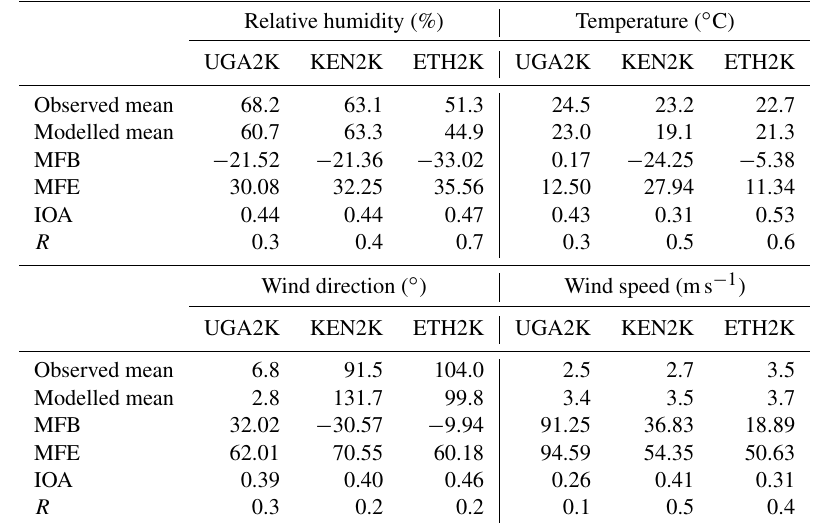
Table 3. Statistical analysis of relative humidity, surface temperature, wind speed, and wind direction averaged over all of the available weather stations for the second nested domains of UGA2K, KEN2K, and ETH2K at a 2 × 2km resolution. The mean observed and modelled values, the Pearson coefficient ( R ), the index of agreement (IOA), the mean fractional bias (MFB), and the mean fractional error (MFE) are